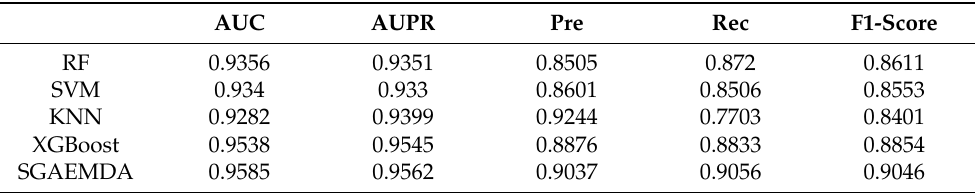
Table 3. Five types of classifier evaluation metrics.